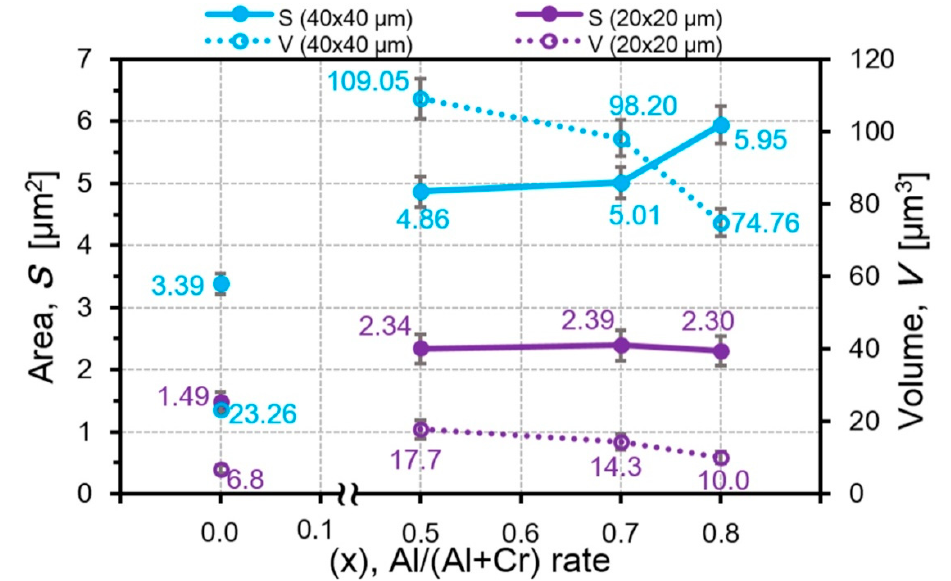
Figure 11. The dependences of the particle area and volume from the aluminum content in the AlCrN coatings.